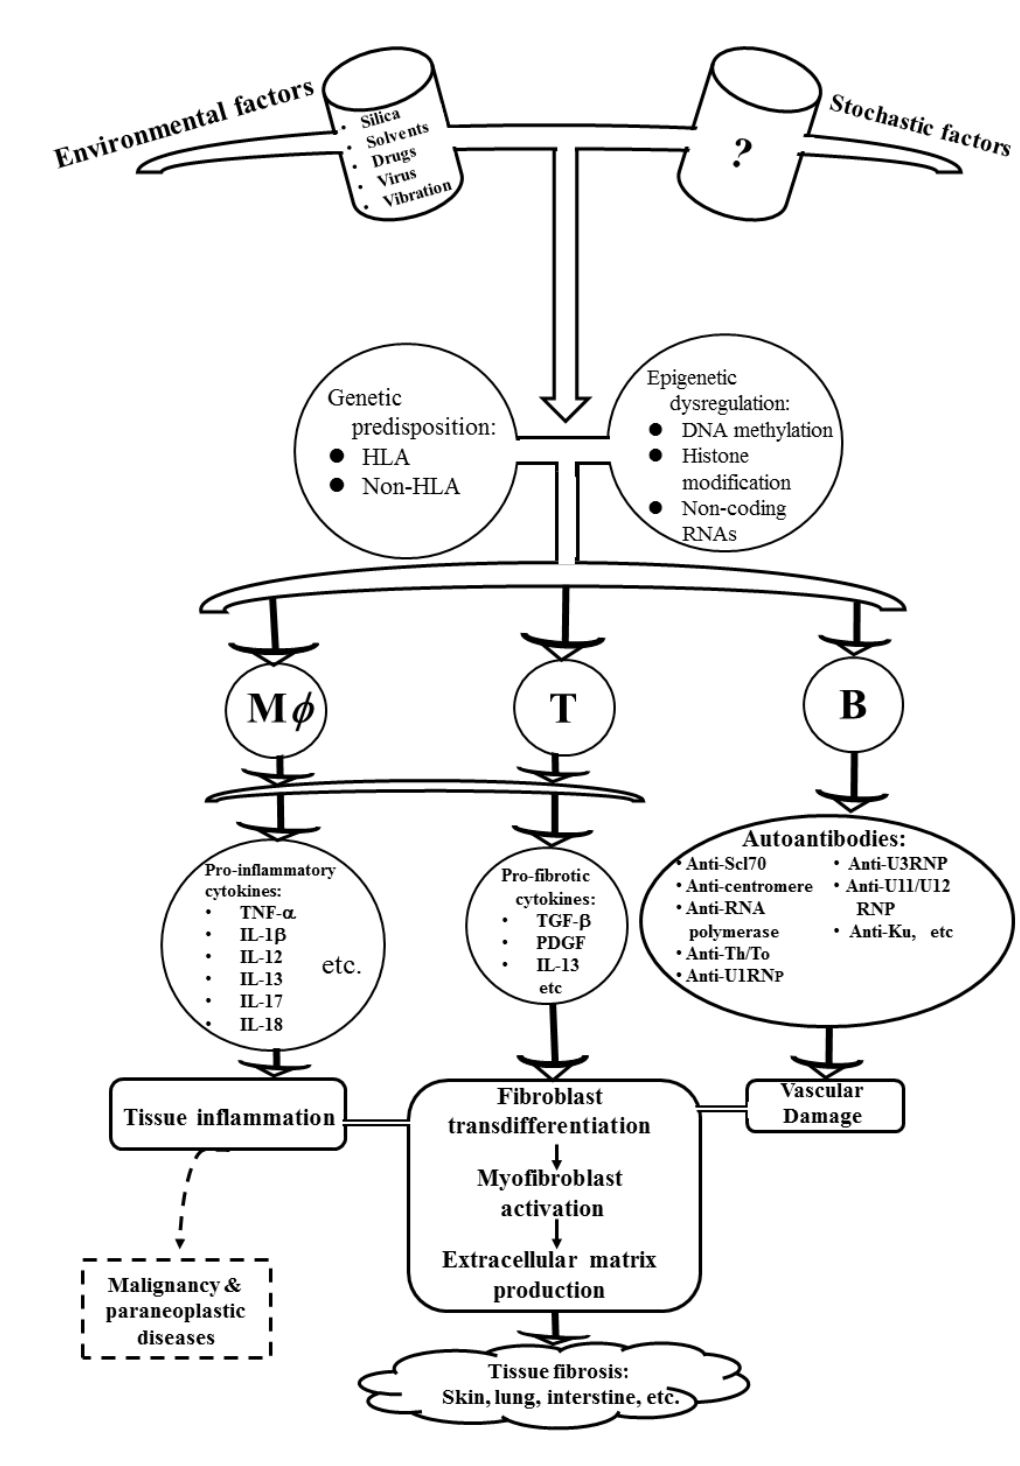
Figure 5. A scheme depicting in detail the contributing factors including genetics / epigenetics predispositions, environmental factors, and the undefined stochastic stresses in inducing aberrant immune responses. These factors may cause vascular endothelial cell damage, vascular smooth muscle hypertrophy, chronic inflammation, autoantibody productions, excessive oxidative stress, and aberrant non-coding RNA expression. These pathological modalities lead to increased trans-differentiation of fibroblasts to myofibroblasts. Finally, tissue fibrosis occurs in the patients with systemic sclerosis.